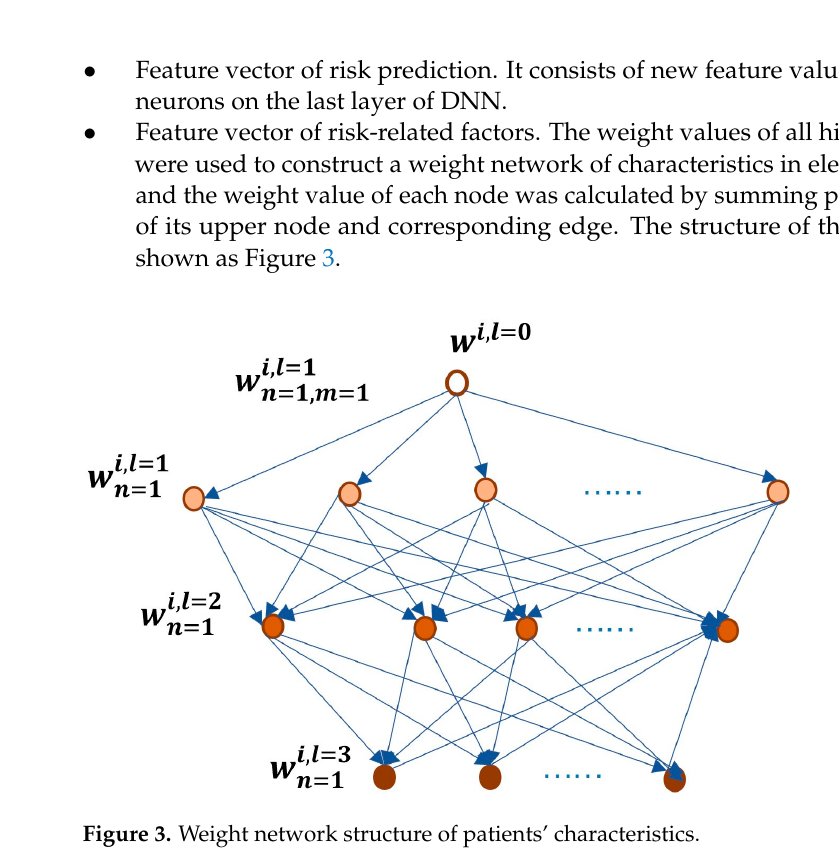
Figure 3. Weight network structure of patients’ characteristics.